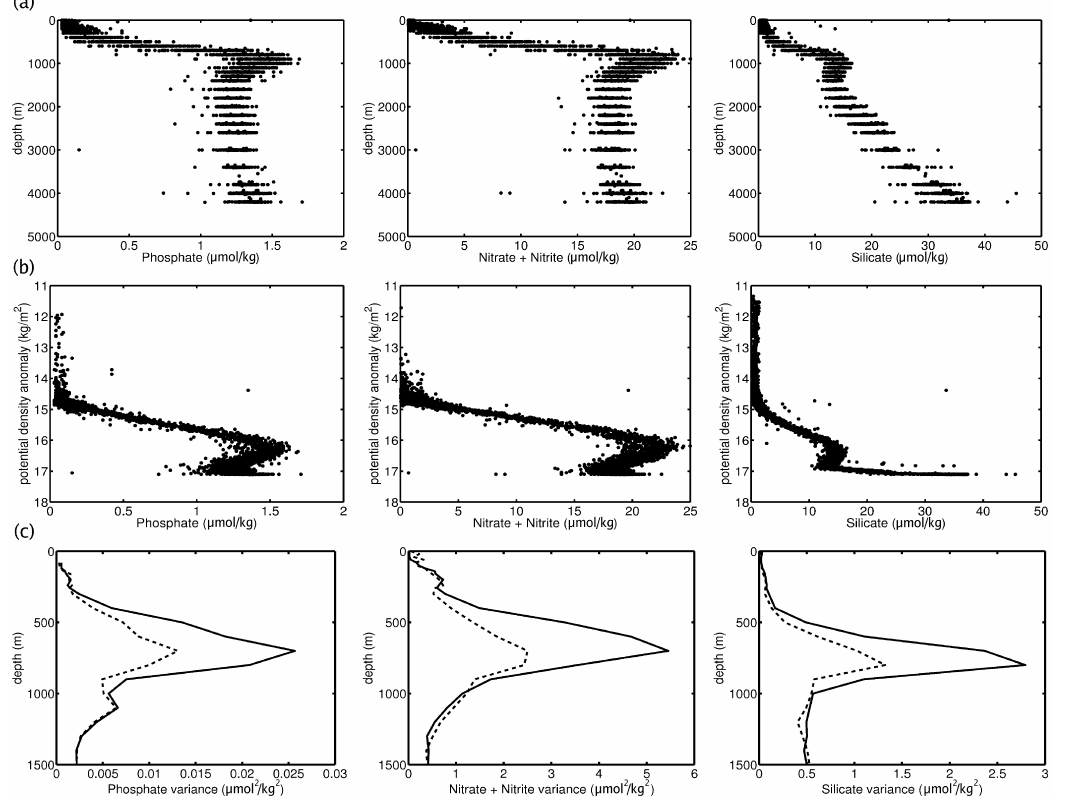
Fig. 1. BATS nutrient concentration data plotted against (a) depth and (b) potential density anomaly ( ρ − 1020kg/m 3 ) referenced to 2000m. Plots on row (c) show the nutrient-depth variance (solid-line) and nutrient-density variance (dashed line; see text for how this was calculated) within the top 1500m of the water